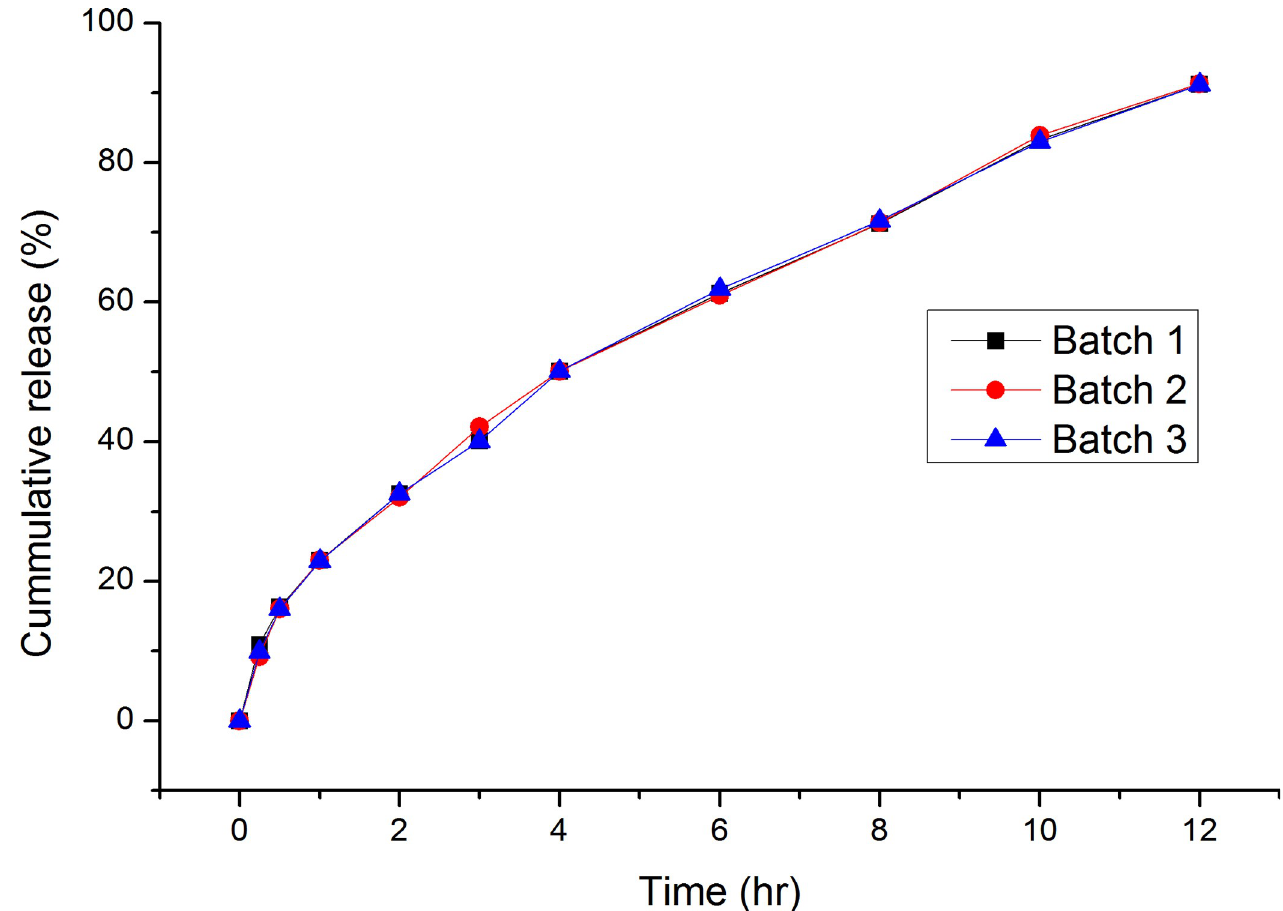
Fig 4. Release profile of optimized formulation of ranitidine HCl matrix tablets.